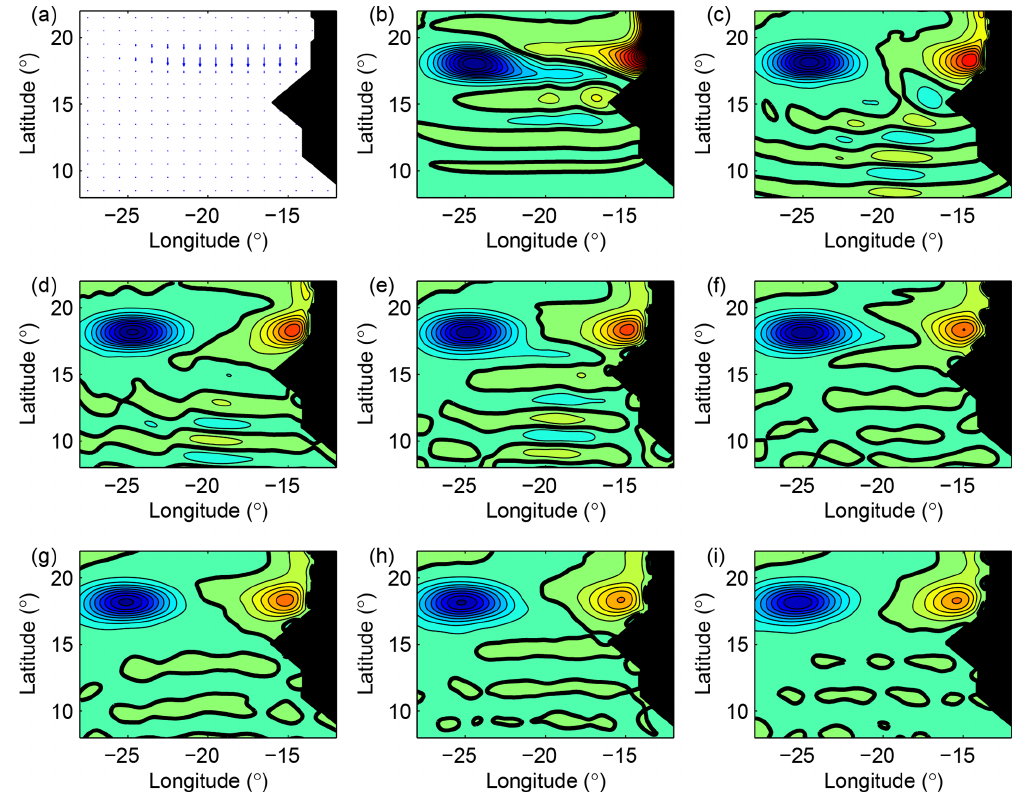
Figure 8. The wind anomaly now acts over a long (1000km) and narrow (200km) domain north of the cape for 5d ( a ). The solution after the close of the wind burst is shown. A wave is generated and the anomaly near the coast has an amplitude comparable with the anomaly around 25 ◦ W. The 0m isoline is indicated in bold; the isoline interval is 0.1m (blue: